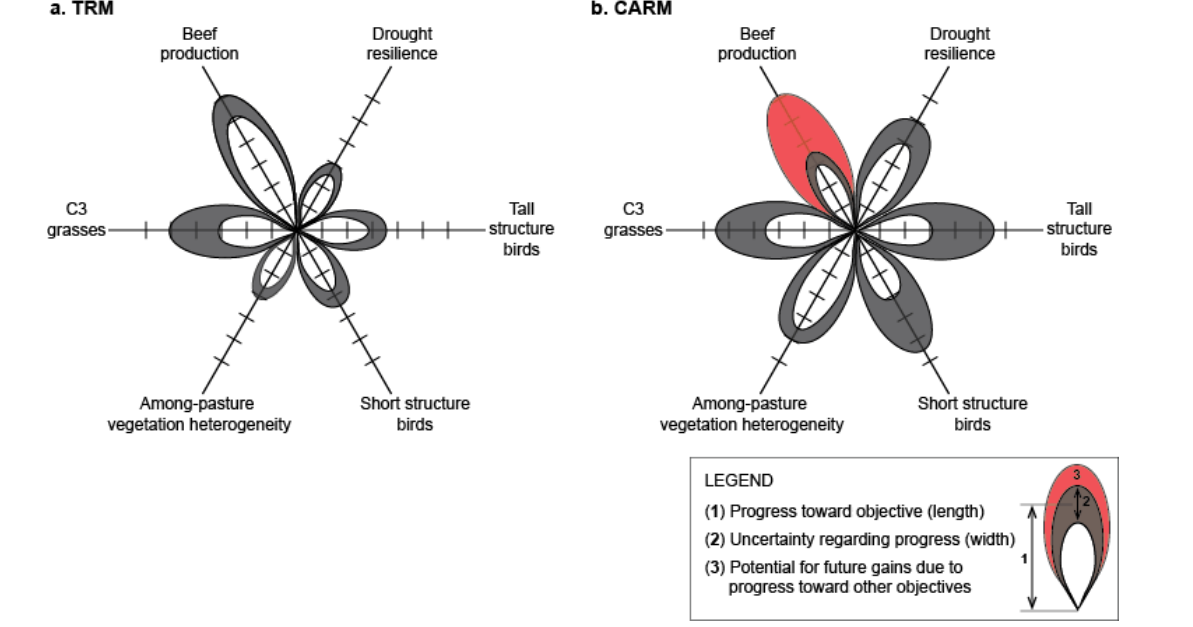
Fig. 7 . Stakeholder-hypothesized progress toward (length of petal) and uncertainty surrounding (width of petal) multiple rangeland management objectives under (a) traditionally managed treatment (TRM) and (b) collaborative adaptive rangeland management (CARM) (b) after two years of treatments. Red petal depicts potential for future gains in beef production because of improvements in vegetation composition and drought resilience in the longer term (5–10